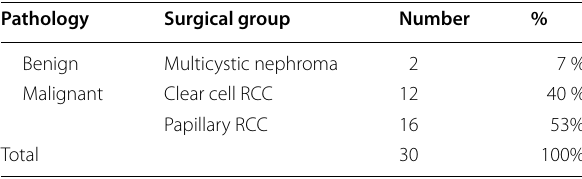
Table 3 Analysis of surgical group as regard histopathology